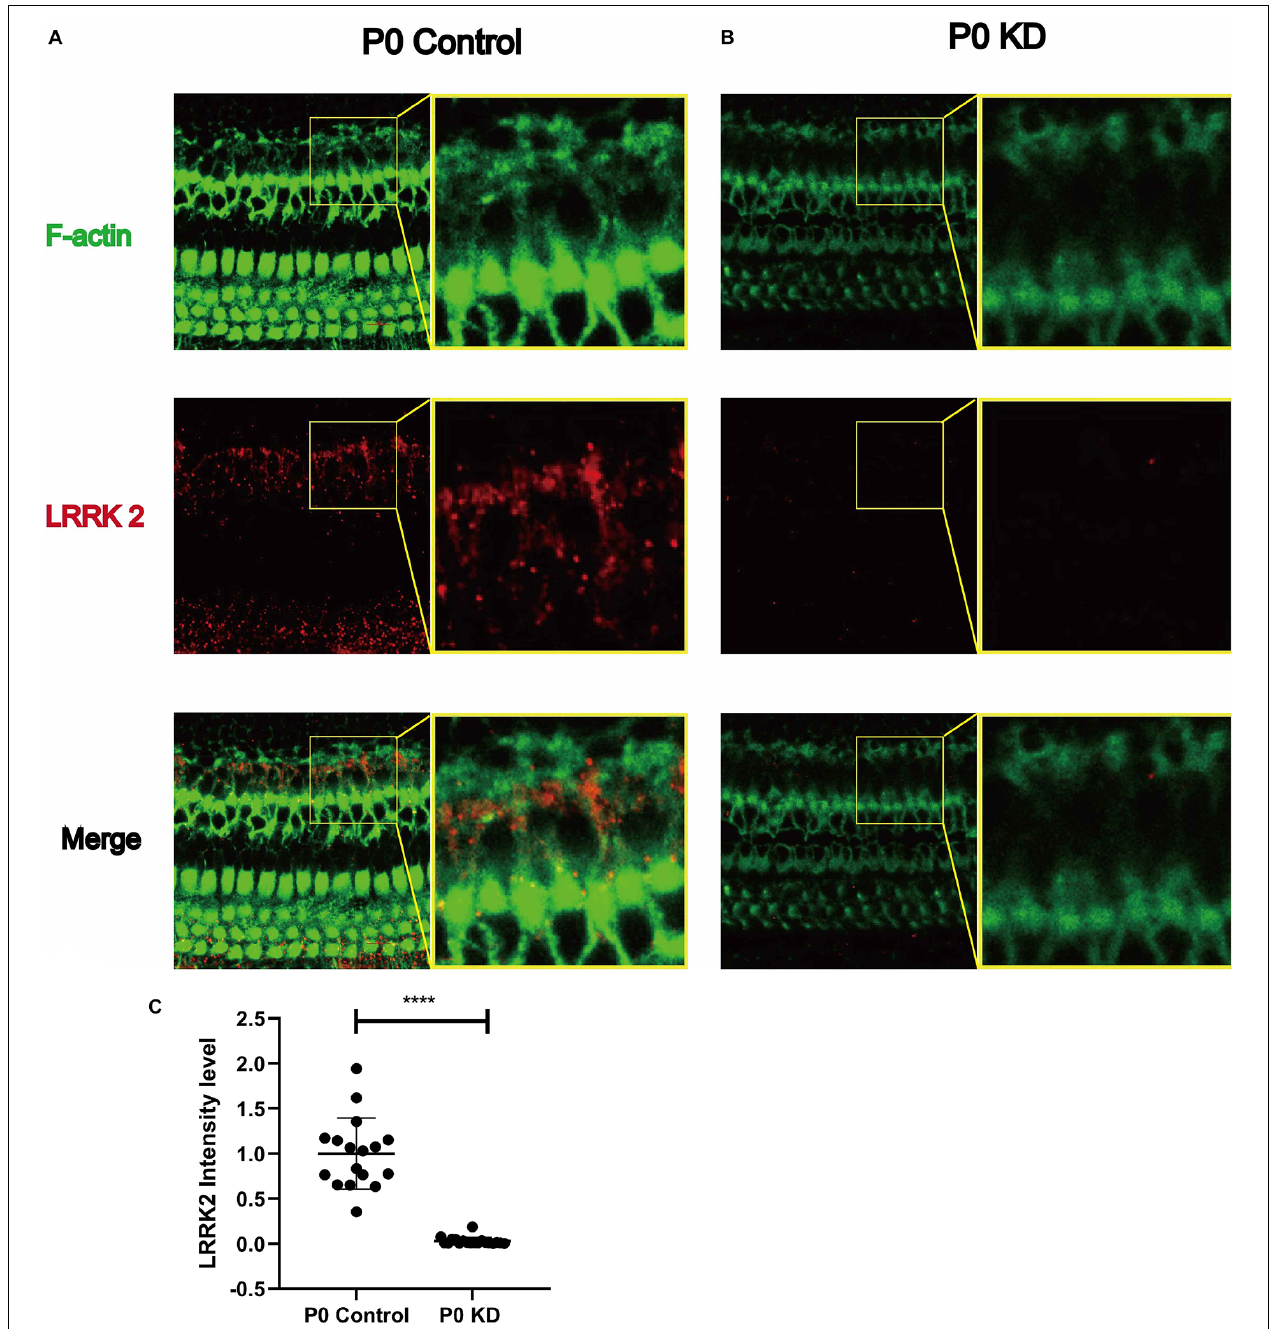
FIGURE 8 | Significant reduction of LRRK2 was observed in the P0 KD group at P6. Immunofluorescence staining of LRRK2 in P0 control (A) , P0 KD groups (B) . Comparison of LRRK2 intensity between P0 KD group and P0 Control group (C) . ****Significantly different from the control group ( P <